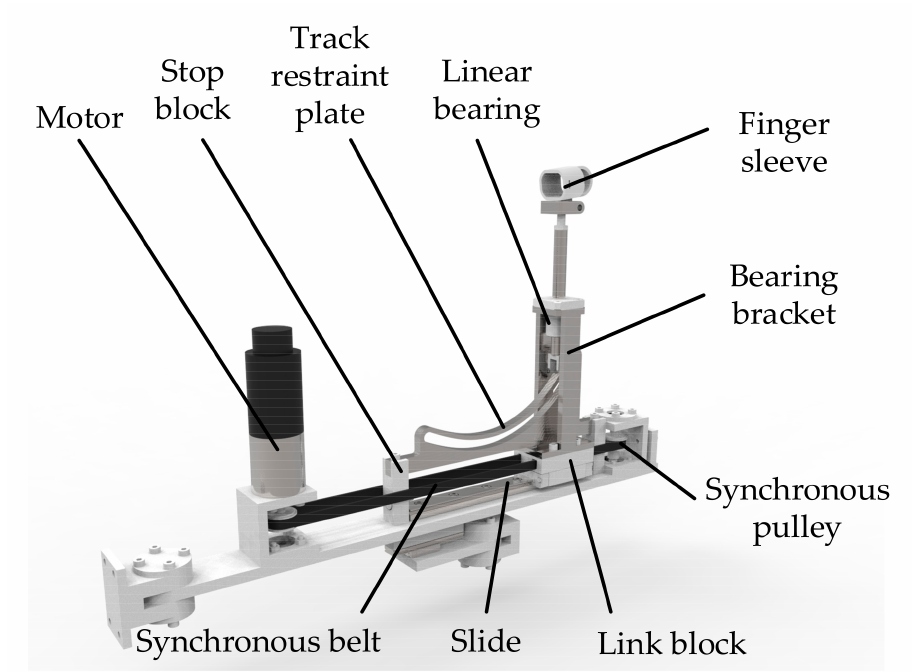
Figure 7. The flexion/extension motion module of the